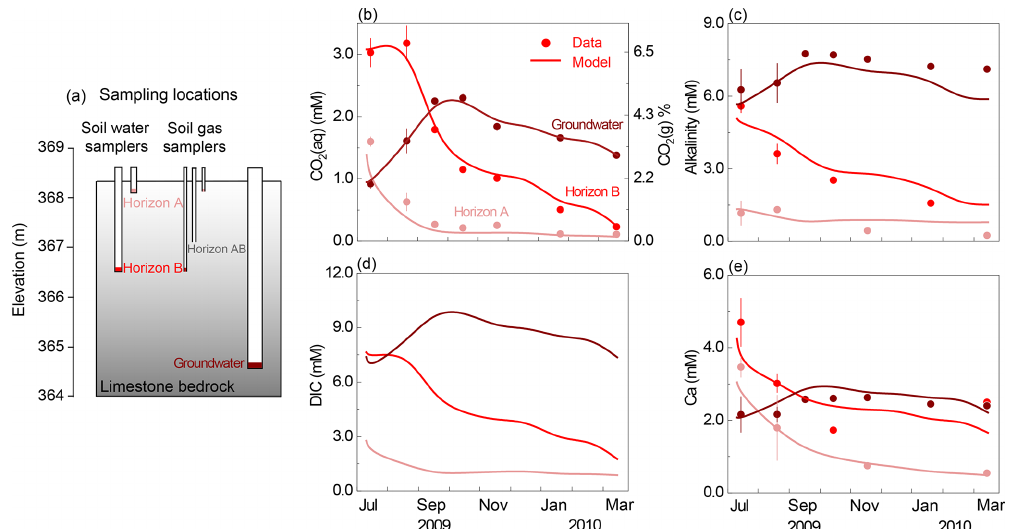
Figure 2. (a) Schematic representation of sampling depths in the Konza grassland; corresponding monthly dynamics of (b) CO 2 (aq) and CO 2 (g), (c) alkalinity, (d) DIC, and (e) Ca concentrations. Lines represent modeling outputs at the corresponding sampling depth of monthly field measurements (dots), including soil water at horizons A (16cm) and B (152cm), as well as groundwater (366cm). The lines of CO 2 (aq) and CO 2 (g) in panel (b) overlapped. Note that there are no DIC data so no dots in panel (d) . The temporal trends of alkalinity, DIC, and Ca mirrored those of soil CO 2 , indicating its predominant control on